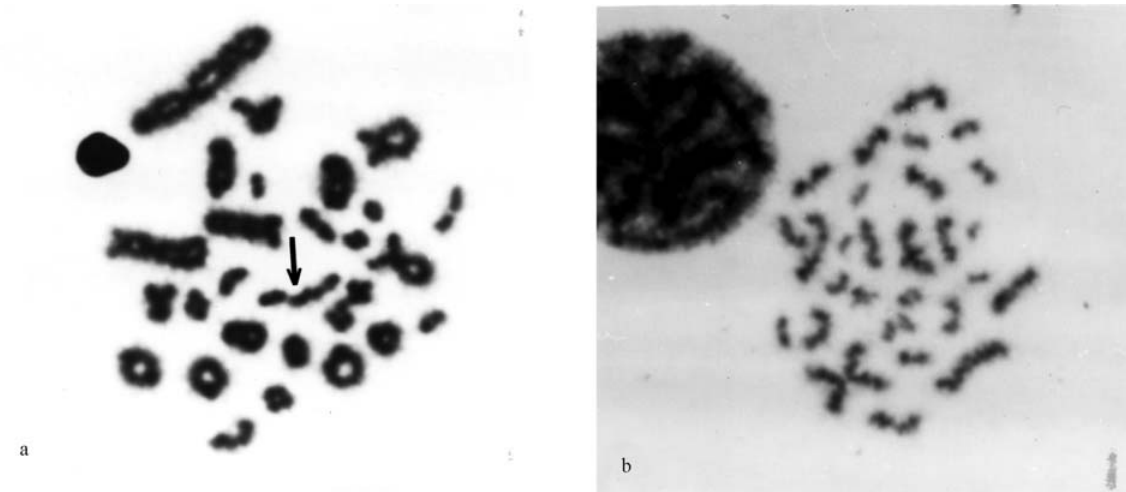
Figure 3 - Meiosis in Calyptommatus . (a) C. sinebrachiatus , diplotene cell with 27 bivalents and one trivalent (arrow) and (b) C. leiolepis , metaphase II with 29 acrocentrics and metacentrics (Figure 6a). The C-banding patterns included weakly stained small regions in some microchromosomes (Figure 7a). R-banding patterns al - lowed the macrochromosomes to be paired and revealed that the distal end of the long arm of pair 2 is a late replicat- ing region (Figure 6b and c). Ag-NORs were located on the telomeres of short arms of a microchromosome pair in 31